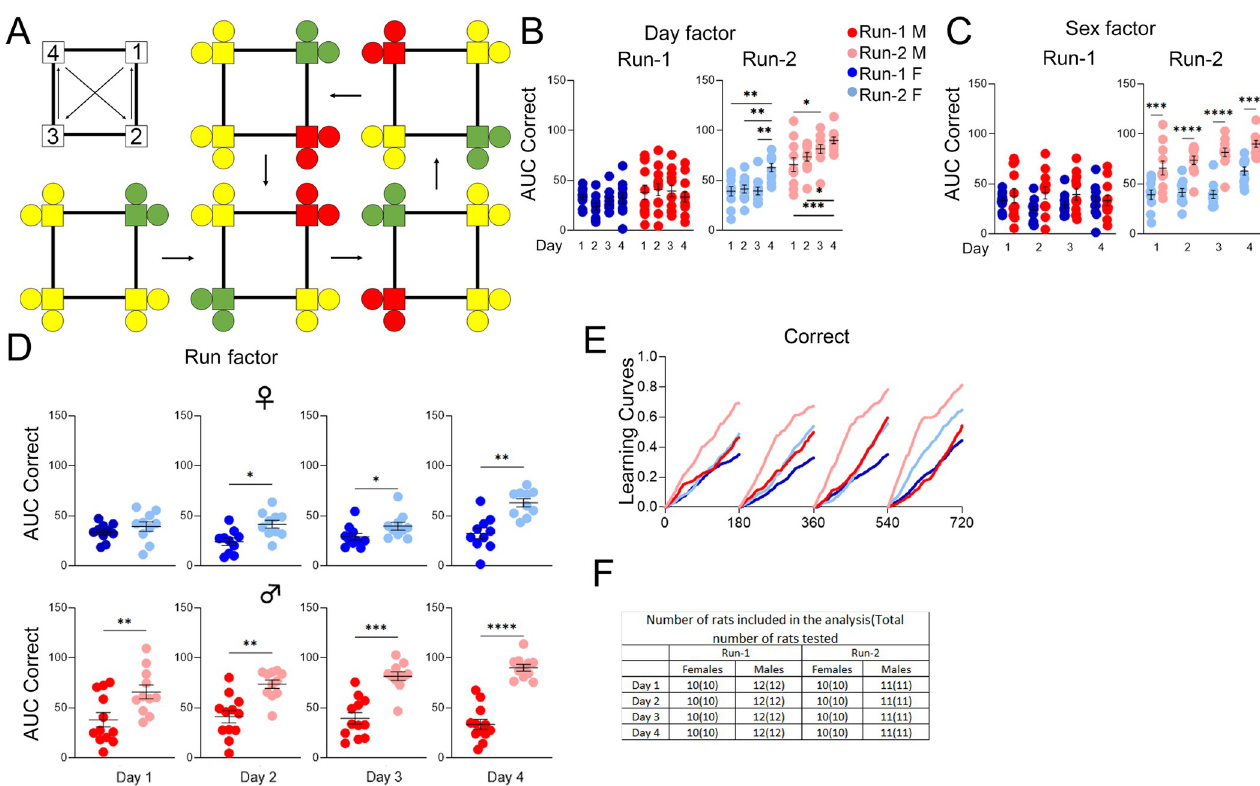
Fig 6. Place learning with corner switch, cohort B. (A) On the top left is the cycle of correct corners with movement every 45 minutes. The rest of the panel, starting from the bottom left, depicts an example of correct (green) and incorrect (yellow, or red highlighting the previously correct corner) layouts for a rat initially assigned to corner 1 and their cycle over the four phases of a drinking session, which ends with the top right layout before returning to the top center layout during the start of the next drinking session. (B) Day factor, (C) Sex factor and (D) Run factor comparisons of area under the curve (AUC) for correct visit activity curves of individual animals by sex, program day, and Run. (E) Activity curves showing the fractional accumulation (y-axis) of correct visits over drinking session time (x-axis), reset every 180 minutes, by sex and Run. (F) For Run-1, 12 male and 10 female rats were tested since 2 females died just before the timeline started. All 22 rats were included in the analysis of Run-1. For Run-2, 11 male and 10 female rats were tested, since one male died during the time between Runs. All 21 rats were included in the analysis of Run-2. All data represented as mean ± SEM ( � p < 0.05, �� p < 0.01, ��� p < 0.001, ���� p < 0.0001,). See Tables 8 and 9 for statistical analysis. Males (M or ♂ ) are colored as red (Run-1) and light red (Run-2). Females (F or ♀ ) are colored as blue (Run-1) or light blue